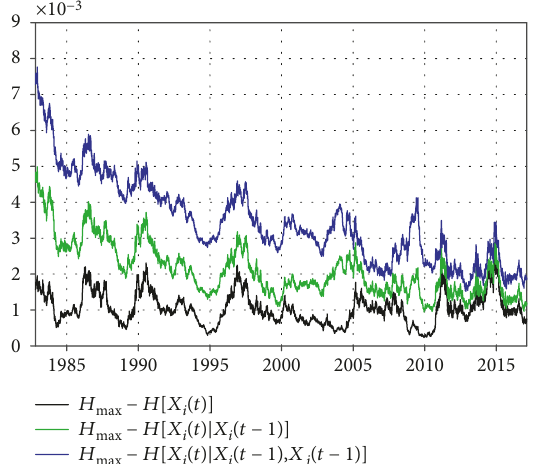
t , H X t ∣ X t − 1 , and Figure 3: Estimated entropies H X i i i t ∣ X t − 1 , X t − 1 for all stocks i and stock pairs i , j H X i i j of the 47 stocks of S&P 500 constituent companies, averaged over all companies i and pairs i , j , and subtracted from the theoretical maximum entropy. The di ff erence H X i t ∣ X i t − 1 − H X i t corresponds to the amount of predictability of time series of fi nancial returns from their own past, and H X t ∣ X t − 1 , X i i j t − 1 − H X t corresponds to the amount of predictability of i time series from both their past and the past of other time series — both of these quantities diminish through